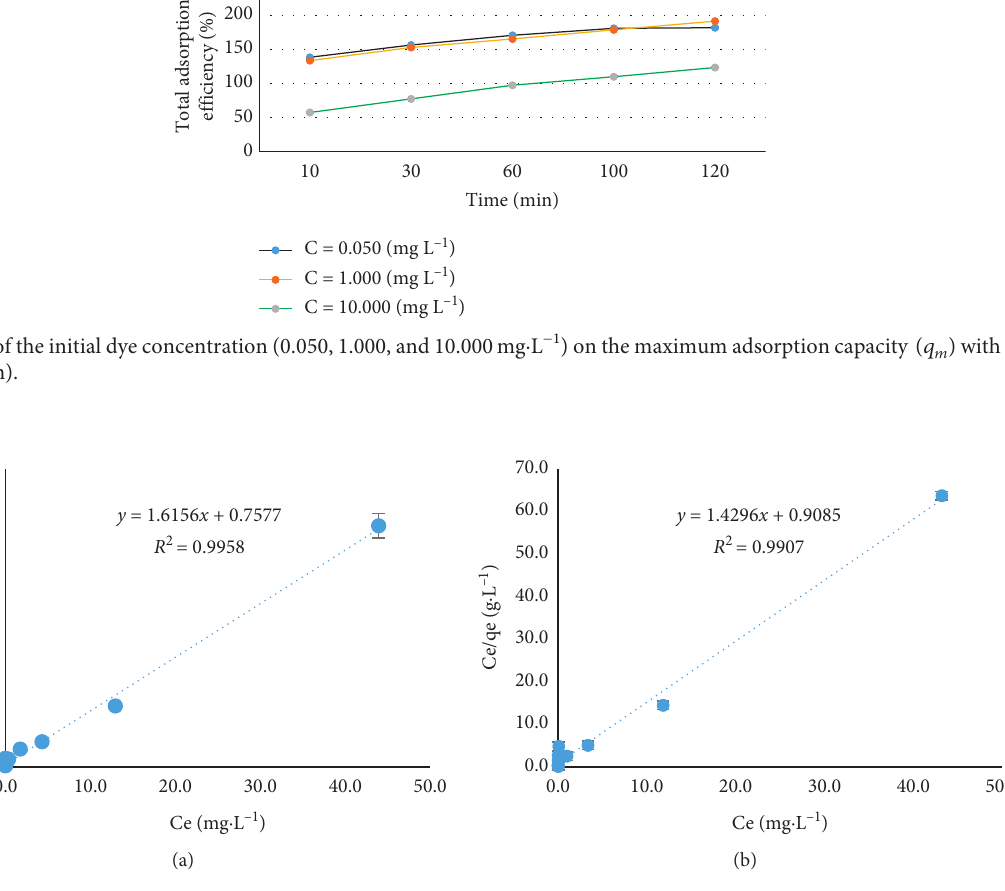
Figure 8: Linear Langmuir plots of Sudan dye adsorption on nanosilica. (a) Sudan I, (b) Sudan II.